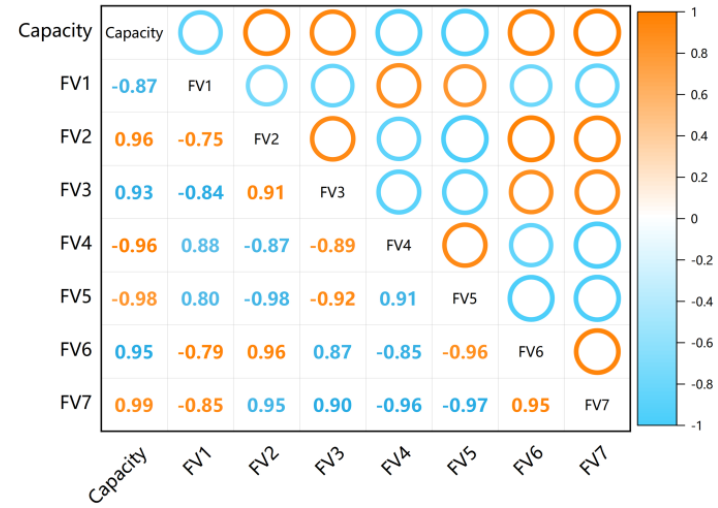
Figure 6. Pearson correlation analysis of capacity and feature values for battery #1. Table 2. Pearson correlation coefficients between feature variables and capacities.